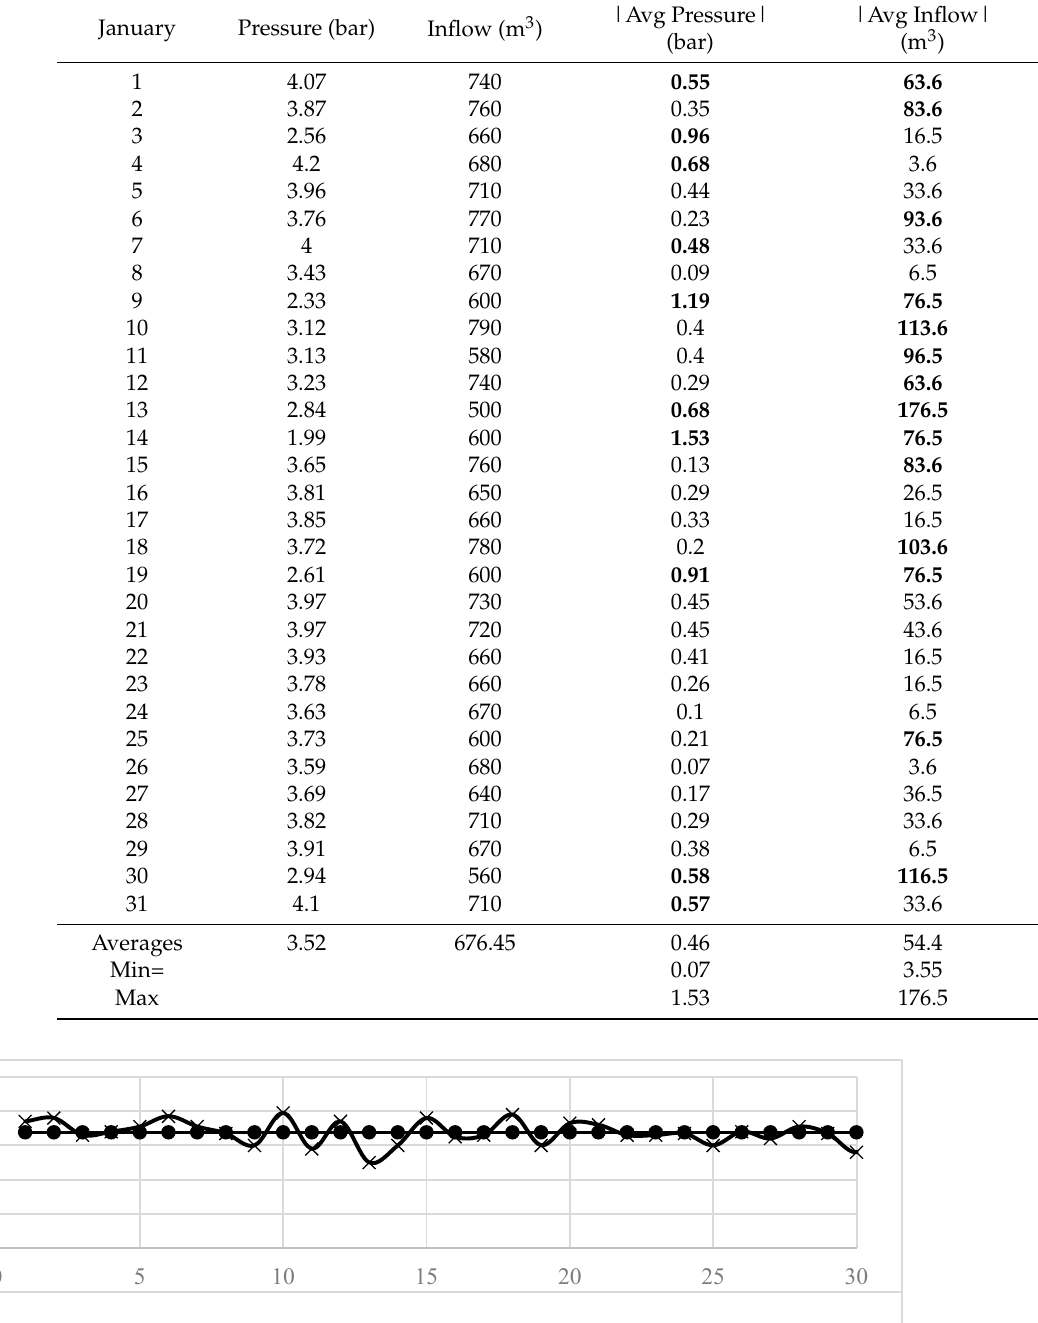
Table 1. Pressure and flow drop calculation.